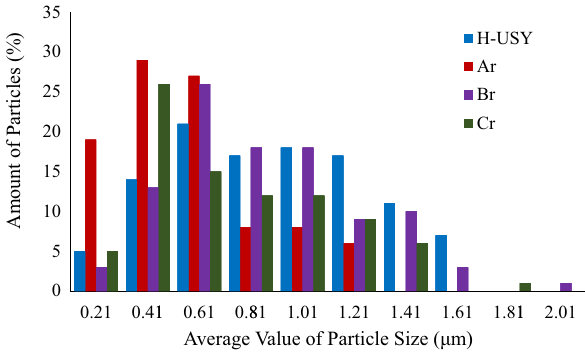
Figure 6: Relationship of average particle size and percentage of